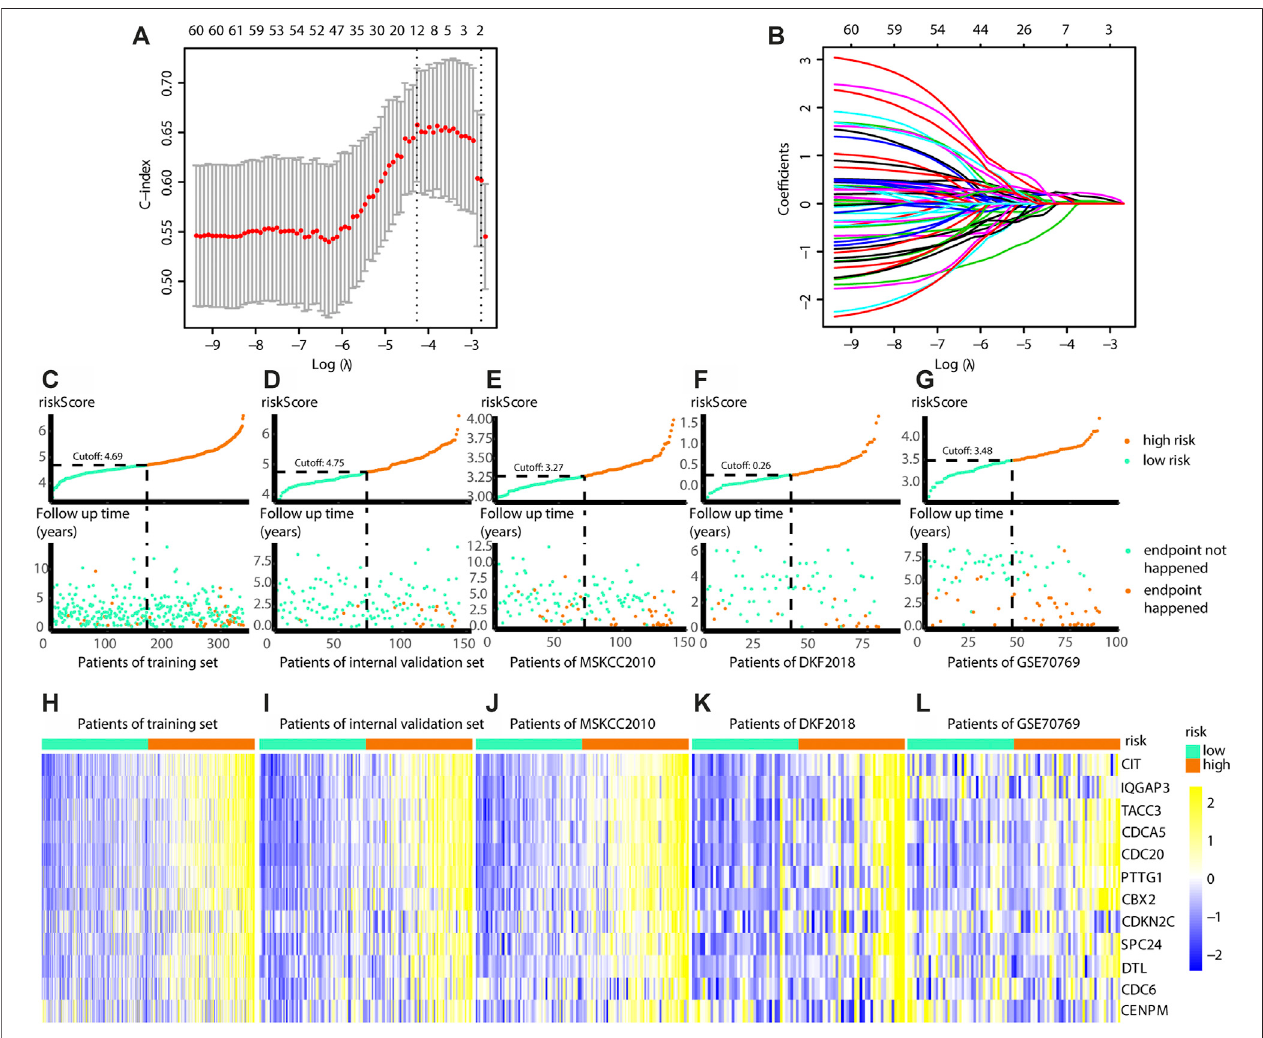
FIGURE 7 | Build the risk model by LASSO. (A) Cross validation based on C-index to determine the best choice of genes in the model. (B) Genes in the different combinations and their corresponding coef fi cients. (C) Patients of training set are arranged in the same ascending order of the risk score. (D) Patients of internal validationsetarearrangedinthesameascendingorderoftheriskscore. (E) PatientsofMSKCC2010datasetarearrangedinthesameascendingorderoftheriskscore. (F) Patients of DKF2018 data set are arranged in the same ascending order of the risk score. (G) Patients of GSE70769 data set are arranged in the same ascendingorderoftheriskscore. (C – G) Patientsaredividedintodifferentrisklevelsaccordingtothemedianoftheriskscoresintheirrespectivedatasets (upward) .The relationship between the survival outcome and risk levels of patients. Low-risk patients are shown on the left side of the dotted line and high-risk patients are shown on the right side (downward) . (H – L) Heatmaps show the expression levels of genes in the model, and indicate the model is robust in these data sets. (LASSO, least absolute shrinkage and selection operator. And p < 0.05 is de fi ned as statistically signi fi cant).